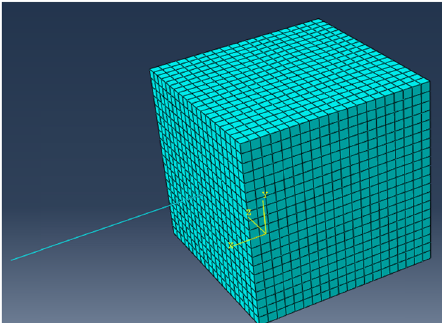
Figure 6: Finite element model meshing.